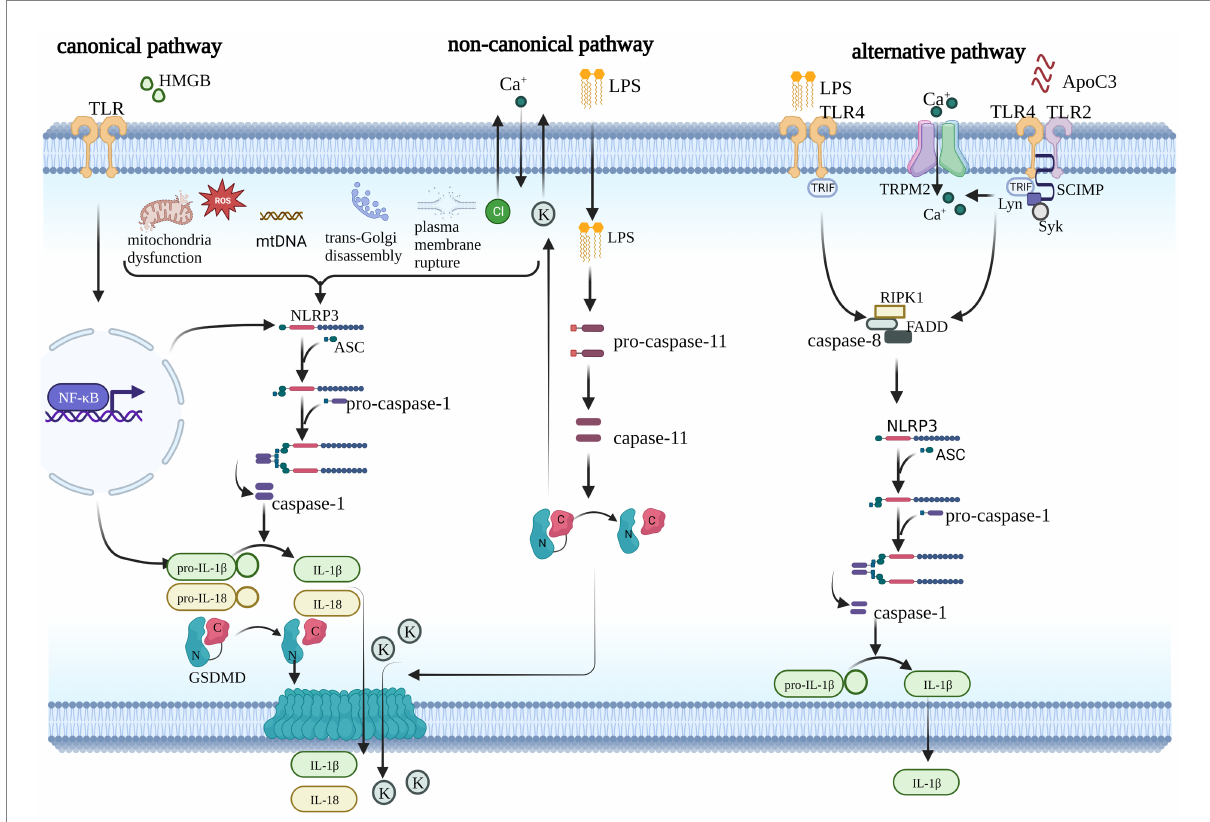
FIGURE 1 Three pathways of NLRP3 inflammasome activation. The canonical pathway requires two steps to complete: the priming step and the activation step. During the priming step, TLR or cytokine receptors sense stimuli and trigger the NF- κ B pathway, which prompts the transcription of NLRP3 and pro-IL-1 β and triggers numerous events upstream of the NLRP3 inflammasome, such as mitochondrial dysfunction, mitochondrial DNA (mtDNA) synthesis, reactive oxygen species (ROS), trans-Golgi disassembly, plasma membrane rupture, and ionic flux. Finally, GSDMD is induced into its active form, which creates pores in the plasma membrane and facilitates cytokine release. Noncanonical signaling is activated by LPS and mediated by caspase11 (caspase-4/5 in humans), which also independently induces pyroptosis and activates the canonical pathway via ionic flux. The alternative pathway does not induce pyroptosis. It is mediated by the LPS-induced TLR4-TRIF-RIPK1-FADD-CASP8 signaling pathway or ApoC3-induced TLR2/4-SCIMP-Lyn-Syk-TRPM2-CASP8 pathway. Caspase-8 promotes the assembly of the NLRP3 inflammasome and cytokine